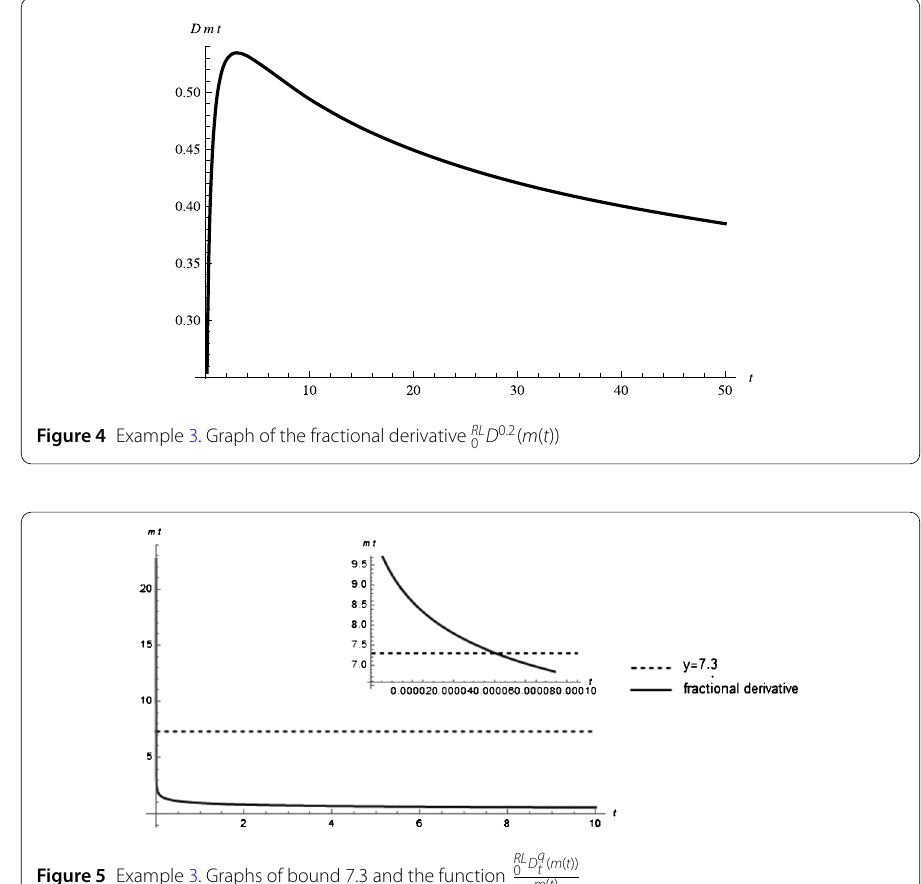
Figure 5 Example 3. Graphs of bound 7.3 and the function